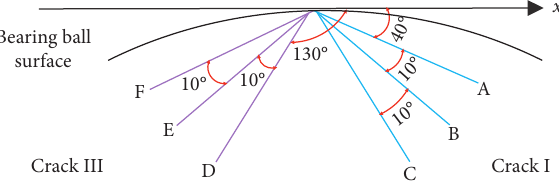
Figure 9: Crack angle distribution